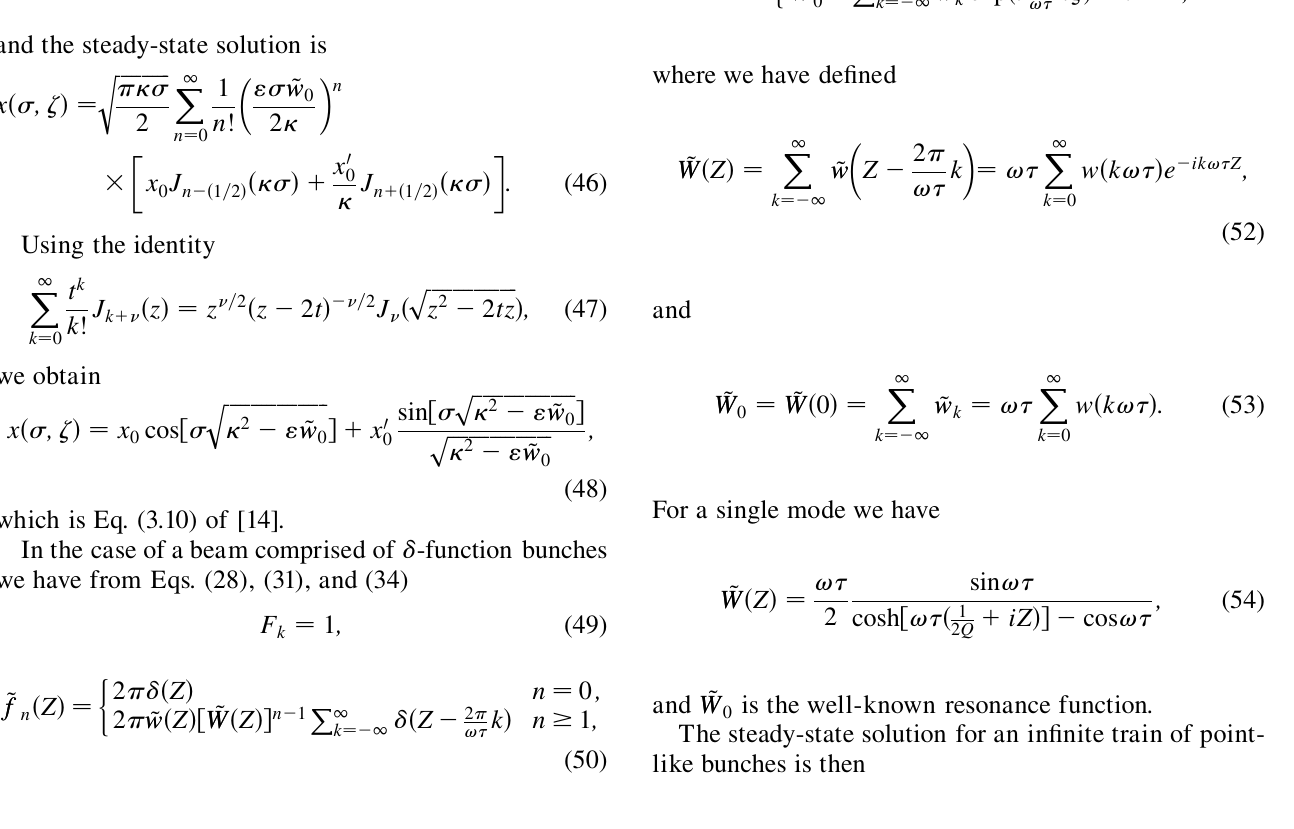
infinite train of finite bunches with / (cid:7) 0 : 1 , Q (cid:7) 10 3 , (cid:8) (cid:7) 100 : 5 ’ , " (cid:7) 0 : 2 , and (cid:4) (cid:7) 1 . (a) assumes !. (cid:7) 4 : 005 ’ , and (b) assumes !. (cid:7) 4 : 001 ’ . Particles inside the bunch are shown in red while those outside are shown in